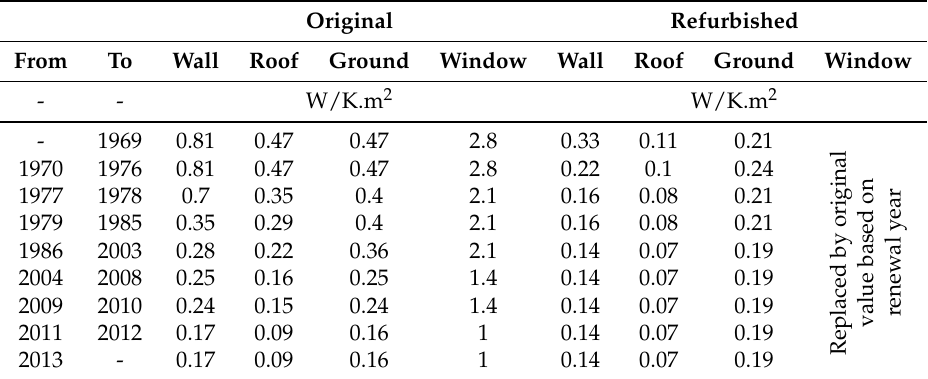
Table 2. U-Values and infiltration rate by year of construction ranges. Original Refurbished Roof Ground Window Wall Roof